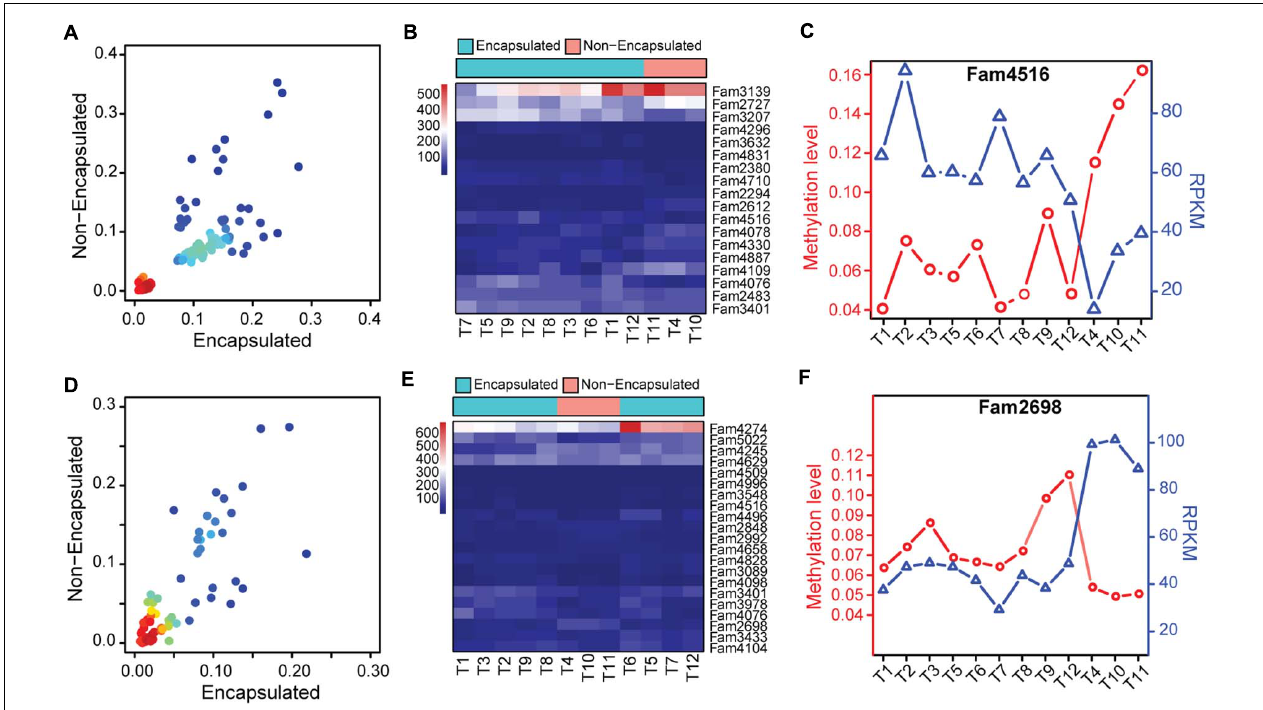
FIGURE 6 | Functional significance of hyper-/hypo-methylated SCOs between the two clades of Trichinella . (A,D) Scatter plot of differentially methylated genes in Ad (A) and ML (D) stages, with density at each point (red for high density, blue for low density). (B,E) Heatmaps depicting the hierarchical clustering of differentially expressed genes that exhibited differential methylation in gene-bodies or corresponding promoter regions in Ad (B) and ML (E) stages between the two clades of Trichinella . (C,F) Methylation and expression levels of fam4516 (C) and fam2698 (F) of the 12